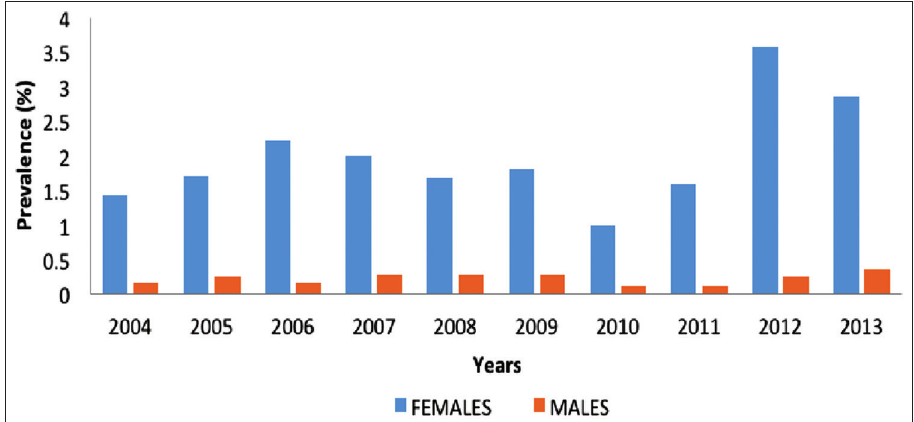
Figure-2: Sex-wise temporal pattern of bovine tuberculosis among slaughtered cattle at Bauchi municipal abattoir